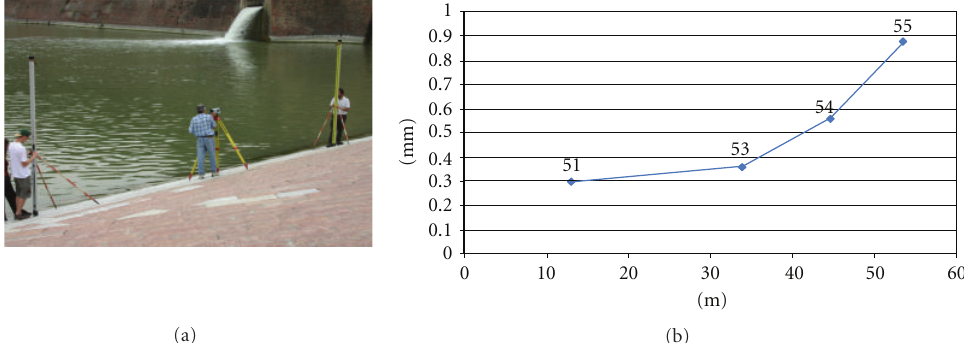
Figure 5: Field operations of high-precision spirit leveling (a); vertical displacements concerning the 2006–2009 time span for four benchmarks located on the bottom of the slide near the damaged zone